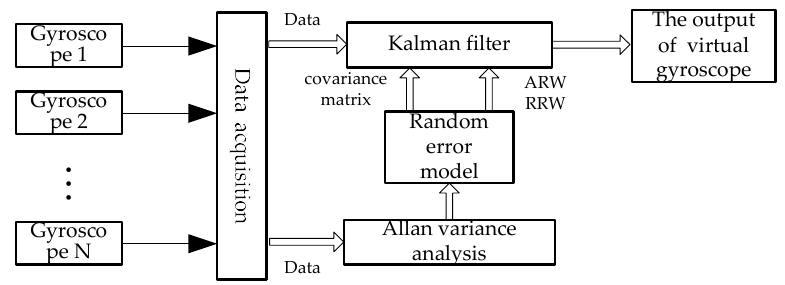
Figure 4. The process of the virtual gyroscope technology.